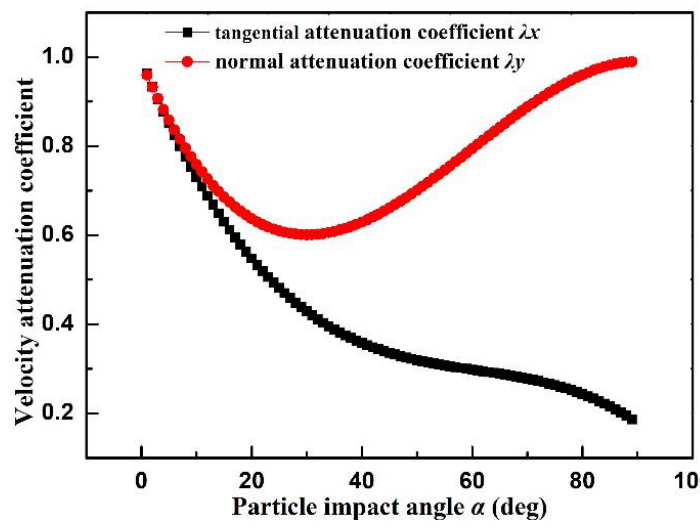
Figure 7. Velocity attenuation coefficient versus different impact angles.